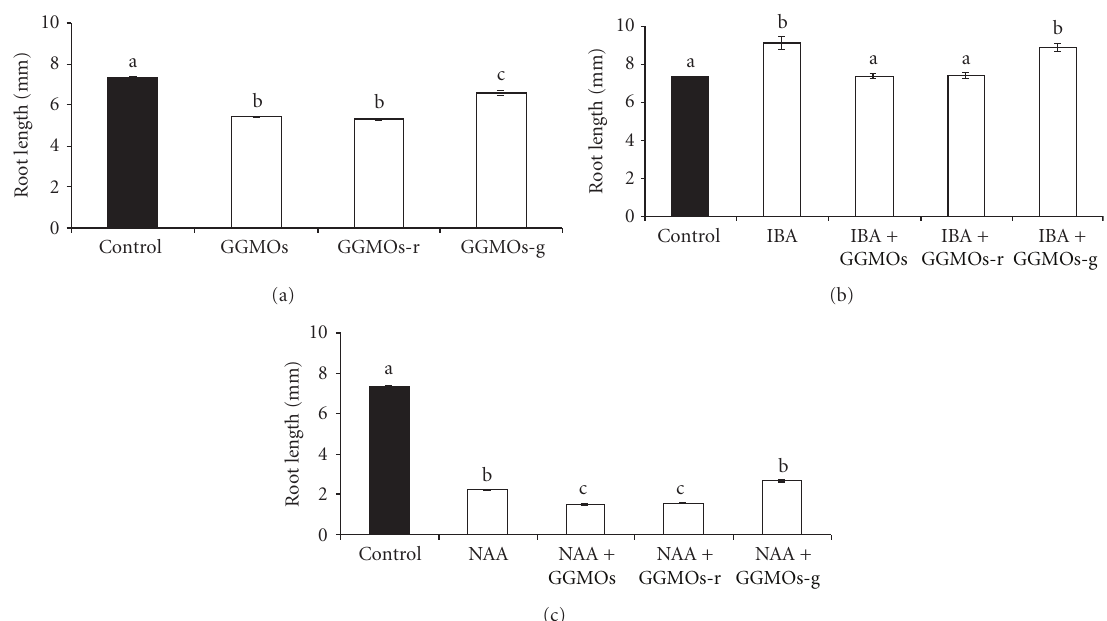
Figure 1: E ff ect of GGMOs, GGMOs-g, and GGMOs-r alone, and in combination with IBA or NAA on mung bean adventitious root elongation. Control—without any plant growth regulators. Di ff erent letters above bars indicate significant di ff erences at P < 0 . 05 according to LSD